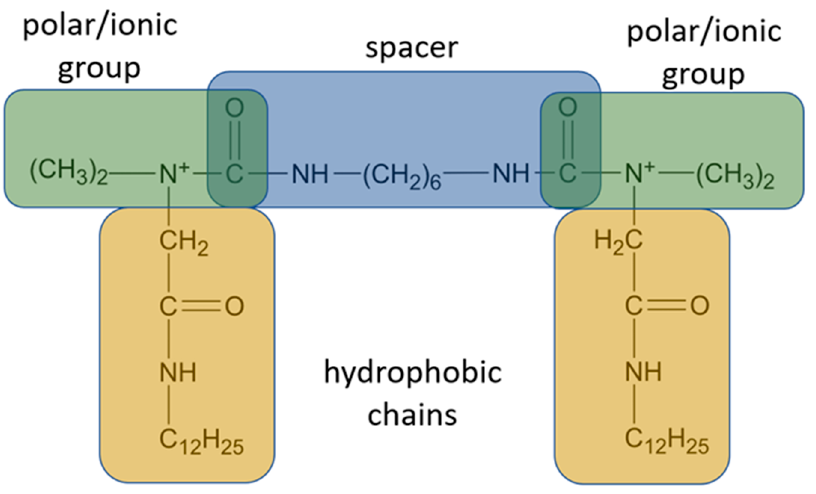
Figure 1. General scheme of Gemini structure classification presented on QAS-type spacer Gemini molecule.